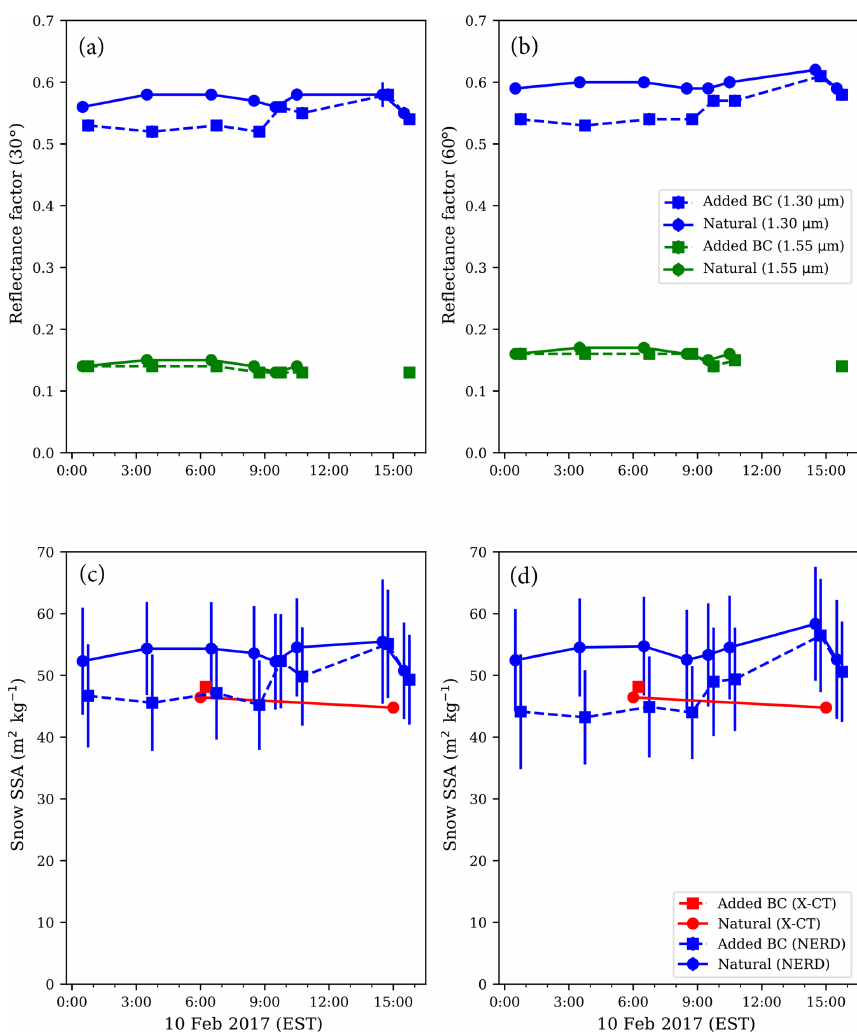
Figure 6. The 10 February control results (mostly cloudy). All panels contain NERD measurement data collected from 00:00 through to 17:00 eastern standard time (EST) on 10 February, 2017. Filled circles connected by solid lines represent measurements on natural snow. Filled squares connected by dashed lines represent measurements on snow heavily contaminated by hydrophobic BC. In panels (a) and (b) , blue (green) curves represent 1.30µm (1.55µm) BRFs at 30 ◦ viewing (a) and 60 ◦ viewing (b) . Error bars represent standard errors calculated from sample averages from as many as eight locations within each 1m 2 plot. In panels (c) and (d) , blue curves represent NERD-calibrated SSAs from 30 ◦ (c) and 60 ◦ (d) viewing BRFs. Red curves represent SSAs derived from X-CT scans. Error bars represent NERD calibration uncertainty computed from regression analysis (standard errors of the